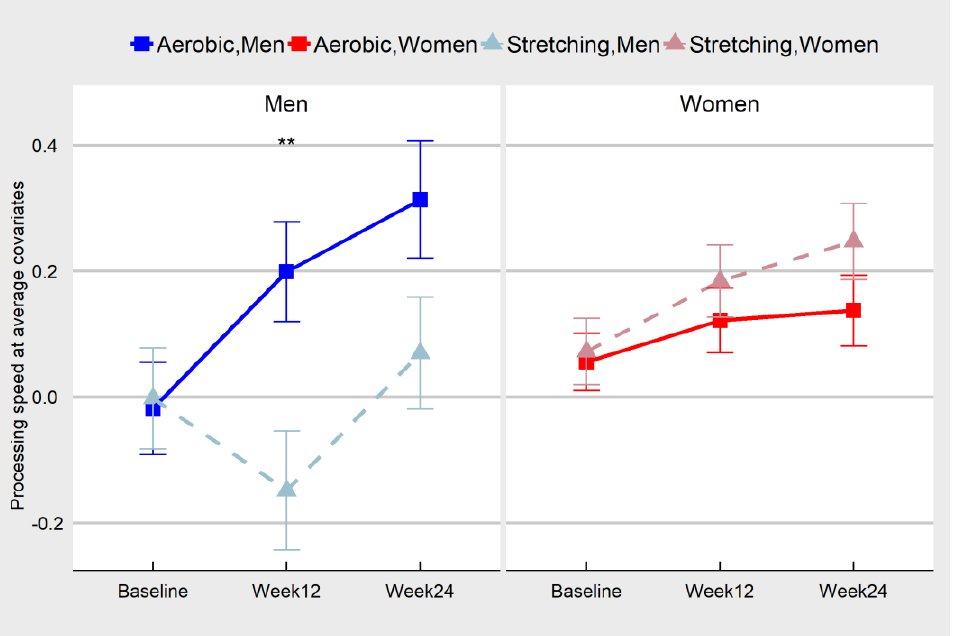
Figure 2. Change in processing speed by condition and sex. There was significant sex moderation while the age moderation was not significant. In men, processing speed in the aerobic group significantly improved by week 12 in comparison to the stretching group, but effect was diminished at week 24 due to slight improvement in the stretching group. In women, there was no aerobic exercise effect at either time point. * p < 0.05; ** p < 0.01; *** p < 0.001.